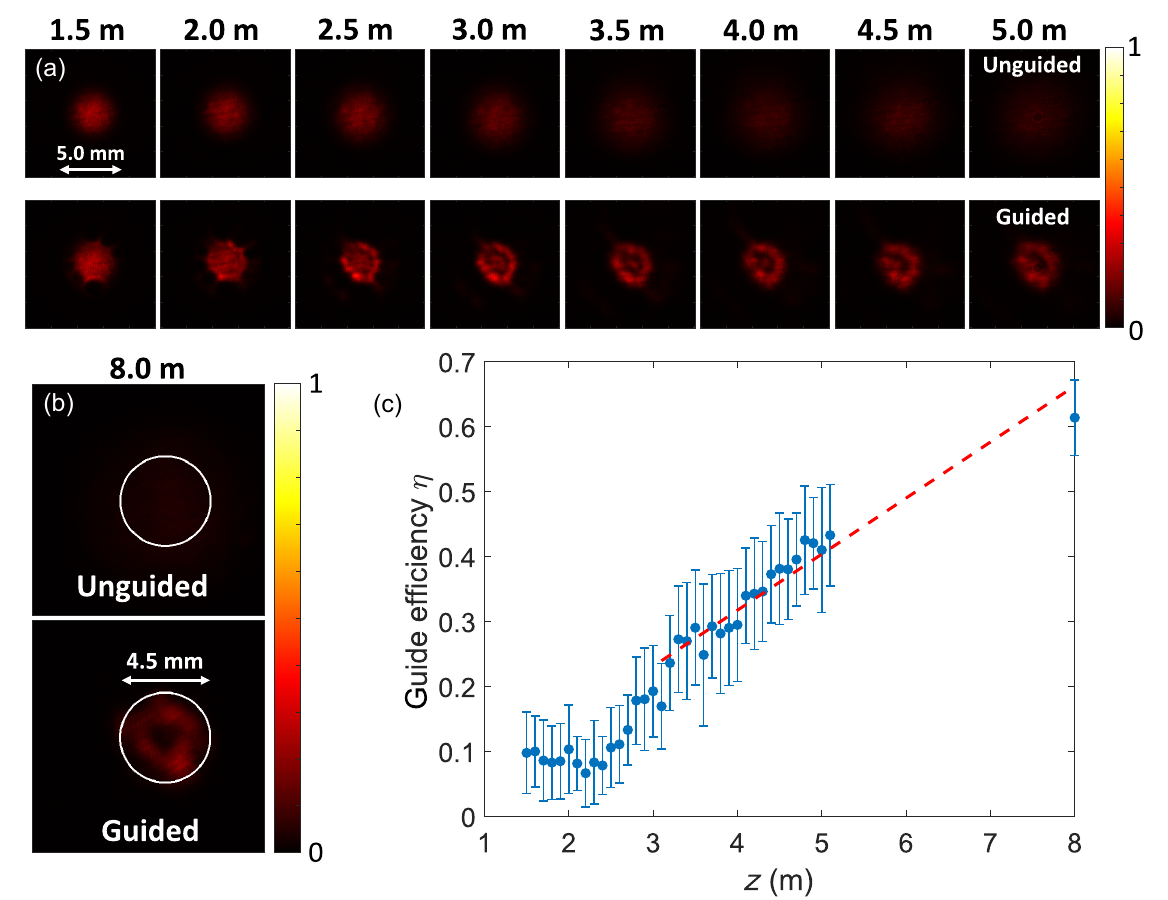
FIG. 5. Optical guiding of a 1-mJ, 7-ns, λ ¼ 532 -nm probe pulse injected at 800 - μ s delay into an air waveguide formed by a 90-mJ, 4 . 5 mm. (a) 50-shot-average images of unguided (top row) and guided (bottom row) mode vs 100-fs LG 01 pulse with d ring ¼ propagation distance. The guided-mode diameter is a constant ∼ 4 mm. (b) Images at z ¼ 8 m of the unguided and guided modes. The 4 . 5 -mm-diameter circles contain the guided and unguided energy used in the definition of guiding efficiency. (c) Guiding d ring ¼ – E – E = ð E efficiency η ¼ ð E vs propagation distance measured with the helium cell. Each point is a 50-shot average, with the g ug Þ tot ug Þ bars showing the (cid:3) standard deviation. The gap between points at z ¼ 5 . 3 and 8 m is due to helium cell travel constrained by our optical table arrangement. The dashed red line is a linear fit to the points > 3 m to guide the